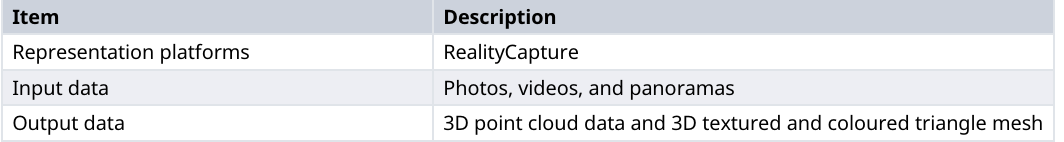
Table 3. Representation phase for the Société Immobilière